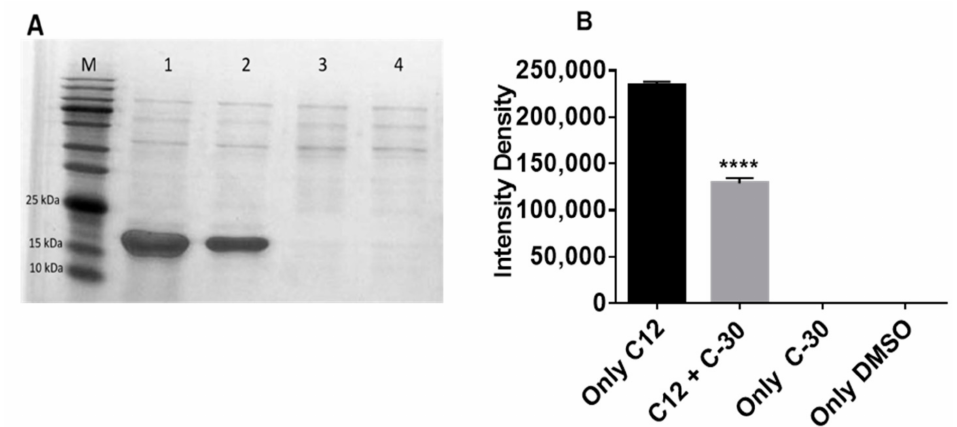
Figure 3. Effect of furanone C-30 on LasR solubility. ( A ) Image of LasR bands after SDS–PAGE, prepared using the ImageJ software [43]. C12 represents 3-oxo-C12-HSL and C-30 represents furanone C-30. M: Marker (10–180 kDa); Lane 1: C12 only; Lane 2: C12 + C-30; Lane 3: C-30 only; Lane 4: DMSO (1%, v / v ) only. ( B ) LasR bands intensity density. The final concentration of 3-oxo-C12-HSL and furanone C-30 used were 100 nM and 50 µ M, respectively. **** p <